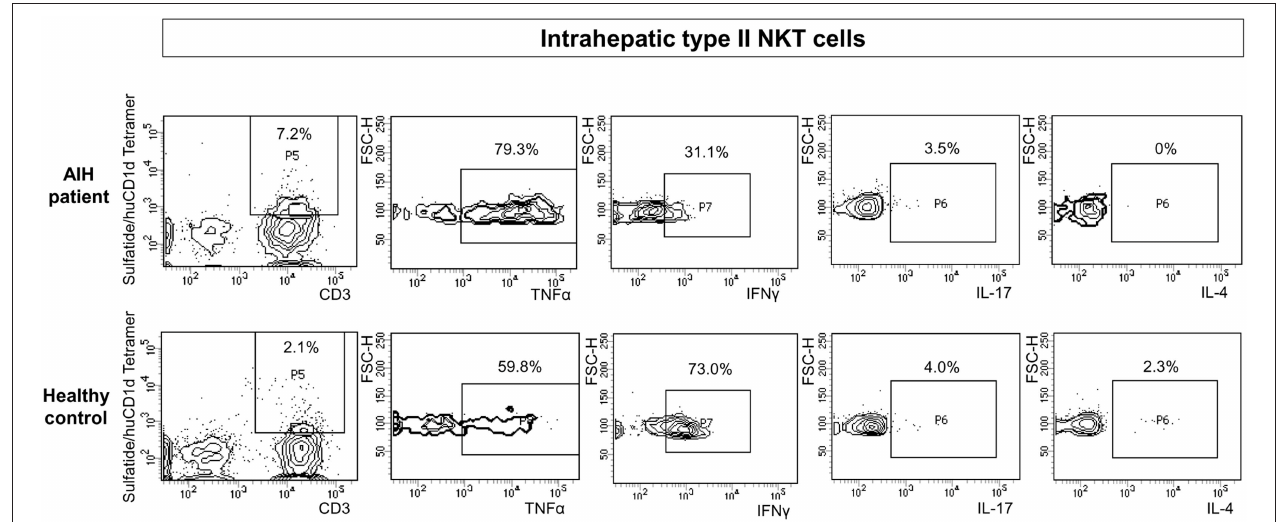
FIGURE 6 | Exemplary flow cytometric intracellular cytokine stainings for type II NKT cells. Representative intracellular cytokine stainings for TNF α , IFN γ , IL-17 and IL-4 for intrahepatic type II NKT cells of AIH patients (upper row) and healthy subjects (lower row) are shown.